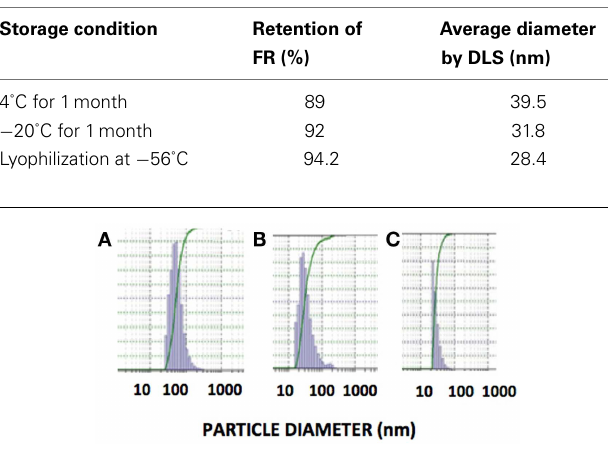
FIGURE 9 | Size distribution of rHDL/FR nanoparticles determined by dynamic light scattering after storage under different conditions. (A) Storage at 4˚C for 1month, (B) Storage at − 20˚C for 1month, (C)